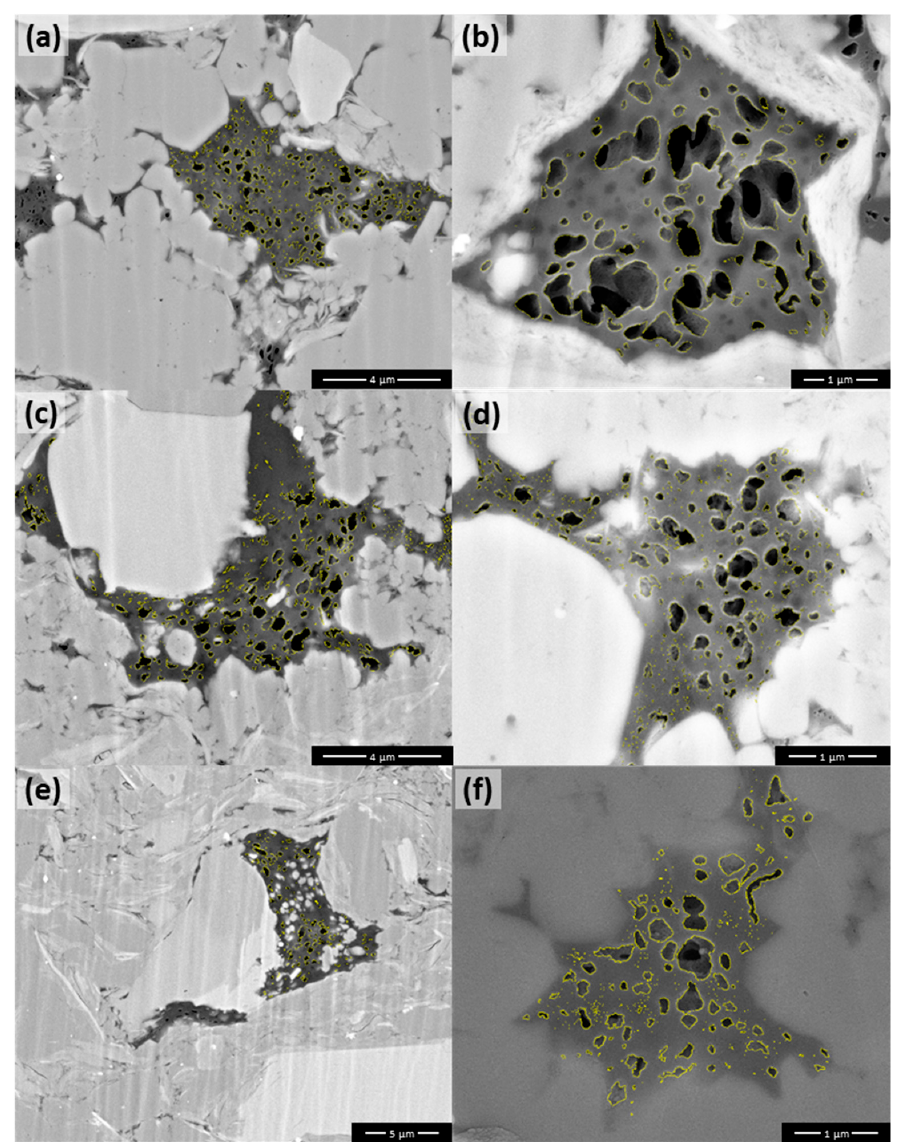
Figure 4. The typical examples of the first subtype of weakly or undeformed porous pyrobitumen (OM I) from Longmaxi-Wufeng Shale, Sichuan Basin. ( a ) SEM image JY1S-9-02 (well ID-sample no.- image no.); ( b ) SEM image JY1S-9-17; ( c ) SEM image JY1S-9-22; ( d ) SEM image JY1S-15-23; ( e ) SEM image JY8S-3-35; and ( f ) SEM image JY1S-12-12. The boundary of OM-hosted pores is outlined in yellow.